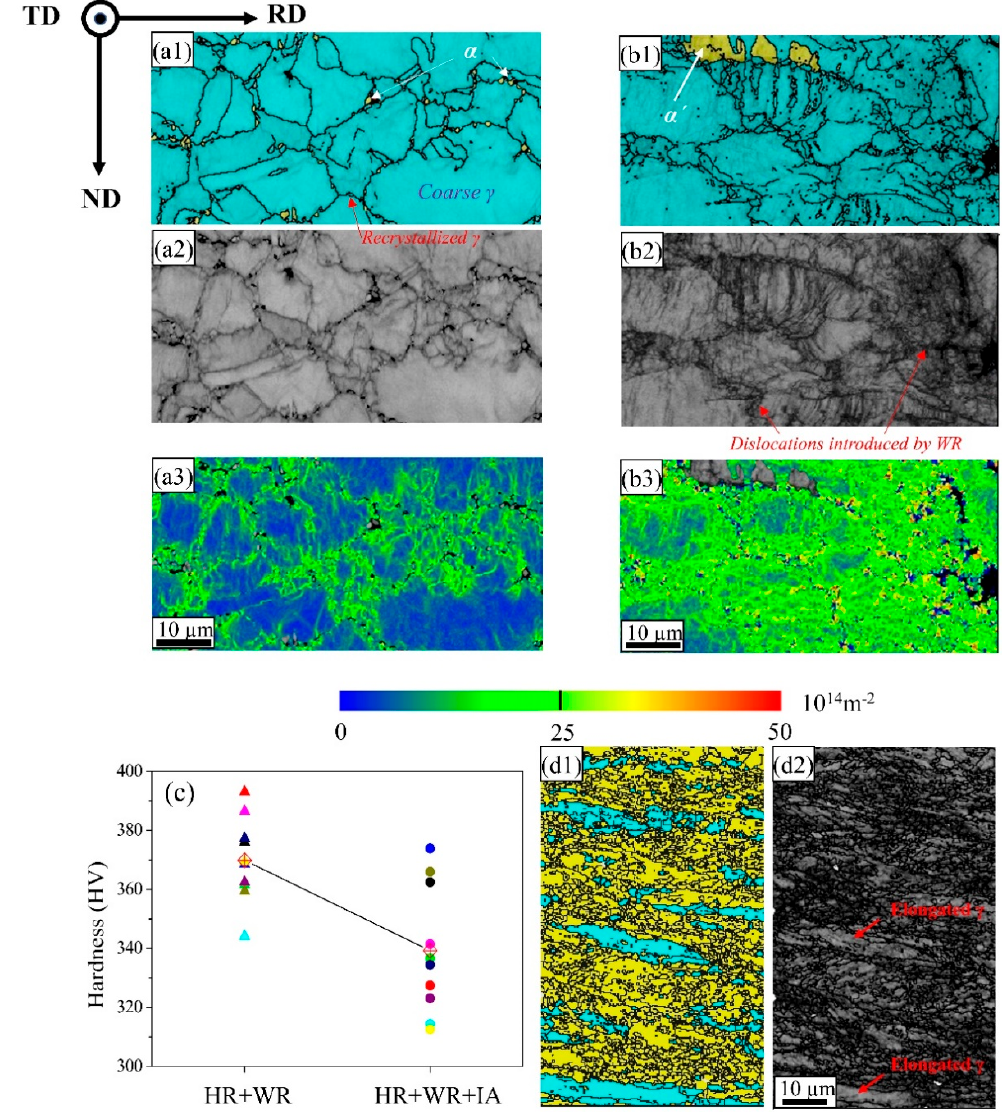
Figure 3. The microstructure of ( a1 , a2,a3 ) HR sample and ( b1 , b2,b3 ) HR+WR sample. ( c ) The Vickers hardness (HV) of HR+WR sample and HR+WR+IA sample. The microstructure of ( d1 , d2 ) D&P samples partitioned at 300 °C for 6 min. (a1, b1 and d1 are electron backscatter diffraction (EBSD) phase maps, wherein yellow and blue colors represent martensite/ferrite and austenite, respectively; a2, b2 and d2 are EBSD band contrast maps; a3 and b3 are the distribution of geometrically necessary dislocations (GND) densities of austenite matrix estimated based on the kernel average misorientation (KAM)). RD: Rolling direction; ND: Normal direction; TD: Transverse direction.